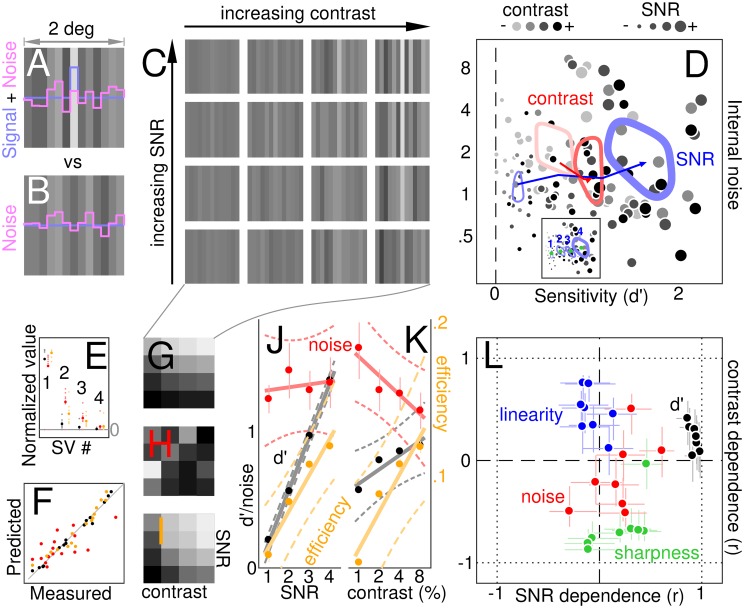
From visual stimulus to summary data descriptors.Observers were asked to discriminate between a signal+noise stimulus (A), containing a central bright bar (blue profile) superimposed onto luminance noise (magenta profile), and a noise-only stimulus (B). Contrast was manipulated by rescaling all luminance values (referenced to background luminance); signal-to-noise ratio (SNR) was manipulated by varying the ratio between luminance of the target signal (central bar) and standard deviation of the noise (see signal+noise example stimuli in C). Each dot in D plots internal noise (y axis) versus sensitivity (x axis) for each subject and each combination of contrast/SNR; dot size reflects SNR, dot colour reflects contrast (light→dark for increasing contrast). Contours demonstrate data spread at low/high contrast (light-red/dark-red) and low/high SNR (thin/thick blue lines); arrow stems join different mean levels from low to high as illustrated by the inset (digits refer to SNR levels 1-4 for the 4 different contours; green dots mark corresponding cluster mean values for each SNR, averaged across contrast levels). Each contour runs along the surface generated by blurring data points with a Gaussian point-spread function of SD equal to 20% of panel width, at a height equal to 80% of surface peak. G-I show sensitivity, internal noise and absolute efficiency for each of the 16 contrast/SNR combinations (mean across observers) as surface plots (increasing value from dark to bright). E plots singular values (SV) for surfaces in G-I (colour-coded as black for sensitivity, red for internal noise and orange for efficiency), demonstrating good degree of separability (large SV#1). F plots each value on each surface in G-I (x axis) against its prediction under separability (y axis). J-K plot marginal averages across the surfaces in G-I (solid lines show best linear fits, dashed lines show 95% confidence intervals around fits; black/red data are plotted to black numerical ordinate values, orange to orange values). L plots contrast dependence (y axis) versus SNR dependence (x axis) for sensitivity (black), internal noise (red), tuning sharpness (green) and linearity index (blue) separately for each participant (one dot per participant; dependence is defined by a correlationn coefficient (r), see insets to Fig 1C and its caption for examples of how it is calculated). Please refer to Methods for how these quantities were computed. Error bars in E,J-L plot ±1 SEM. Error bars are omitted in D to avoid clutter.